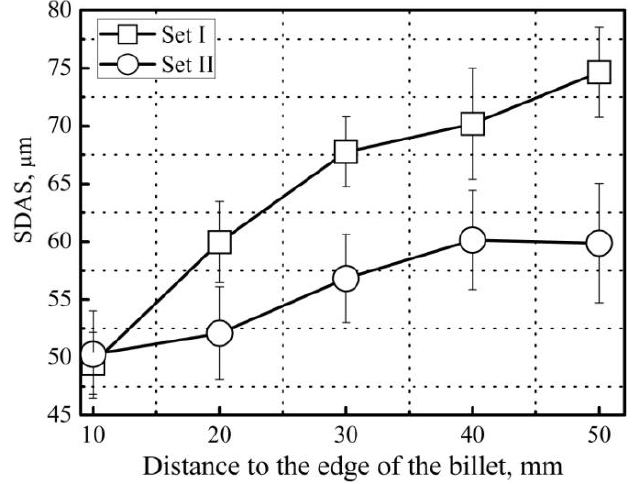
Figure 5. Variations of the secondary dendrite arm spacing (SDAS) with the distance from the edge to the centre of specimen.